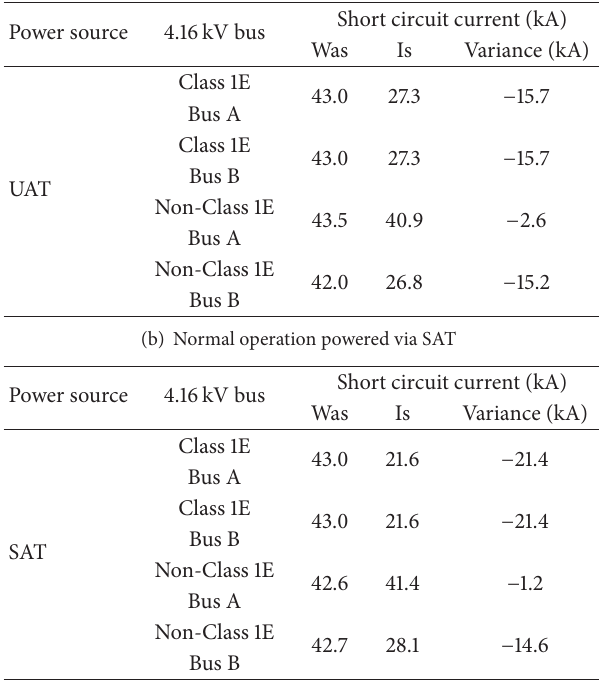
Table 11: Variance in short circuit current during the normal operation with EDG test condition (Cat.